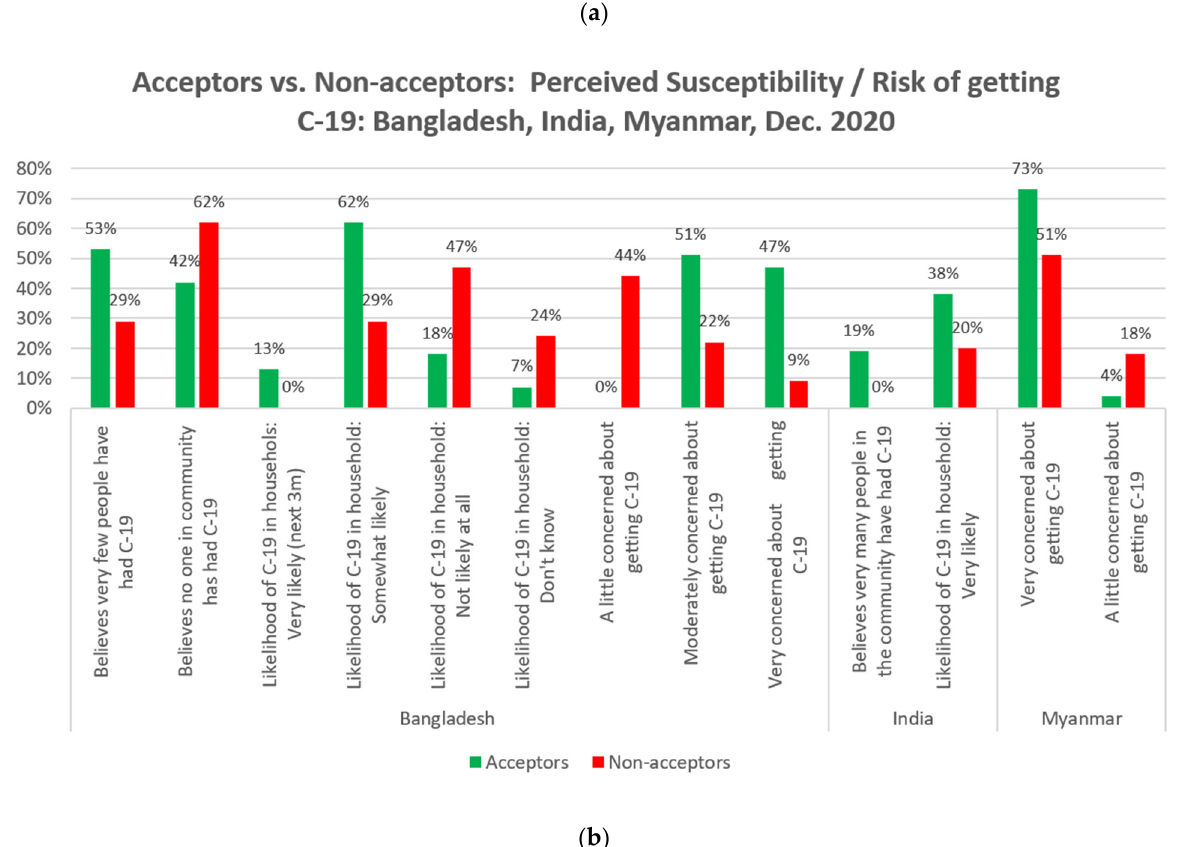
Figure 7. ( a ): Perceived susceptibility/risk of getting COVID-19 in DRC and Tanzania. ( b ): Perceived susceptibility/risk of getting COVID-19 in Bangladesh, India, and Myanmar.